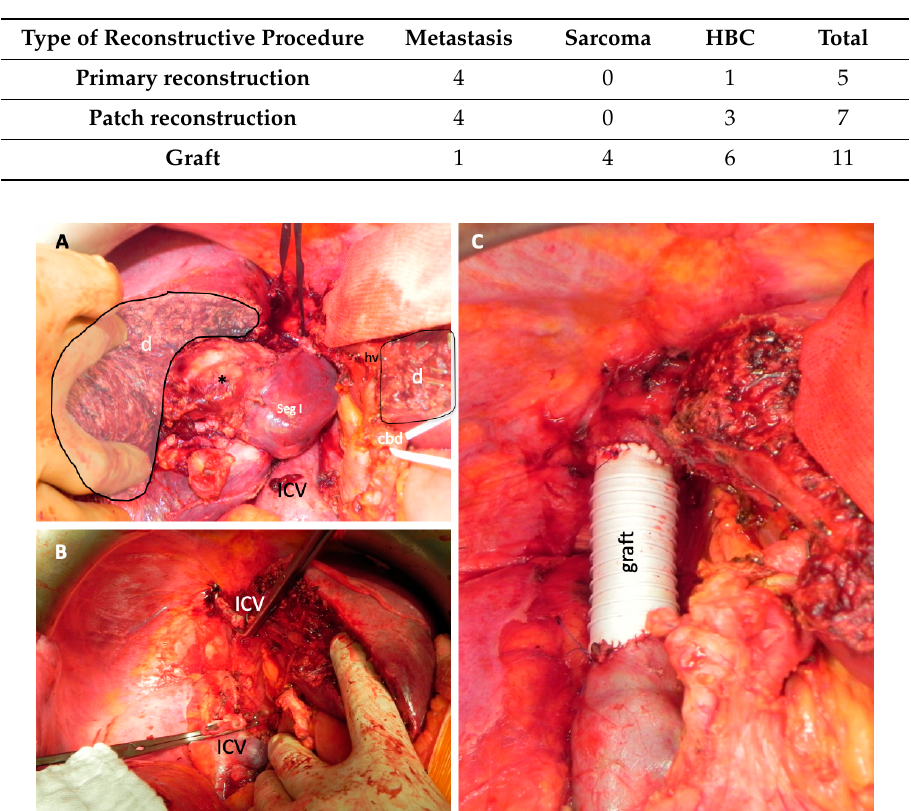
Figure 4. Intraoperative images obtained from a patient who received a GORE-TEX ® interposition graft for the reconstruction of the ICV. The tumor, which was located in Segment I, infiltrated the ICV and the right pedicle. ( A ) The status after the dissection of the parenchyma (d) is shown. The middle hepatic vein (MHV) and the common bile duct (CBD) are located at the right side of the picture. The ICV is located at the bottom of the picture. ( B ) The status after the resection of the right liver with Segment I and the ICV, which is clamped in this picture, is shown. ( C ) The status after the reconstruction of the ICV with a GORE-TEX graft is shown. Table 3. The number of patients receiving a specific type of ICV reconstruction by oncological indication. In the HBC and the sarcoma groups, the reconstruction by means of a graft prevails, whereas patients with metastases were less likely to receive a graft.